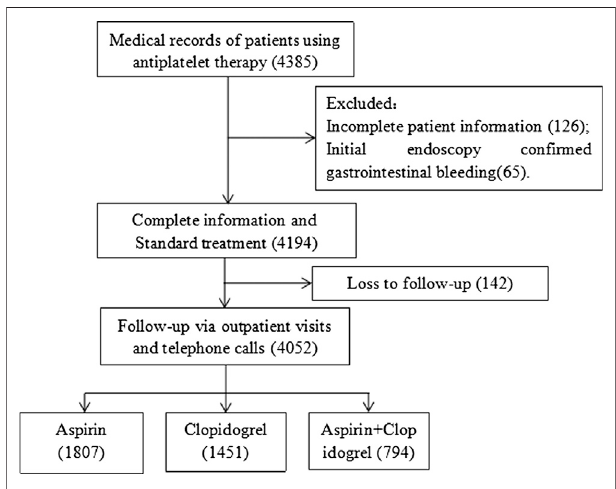
FIGURE 1 | Flowchart of patient